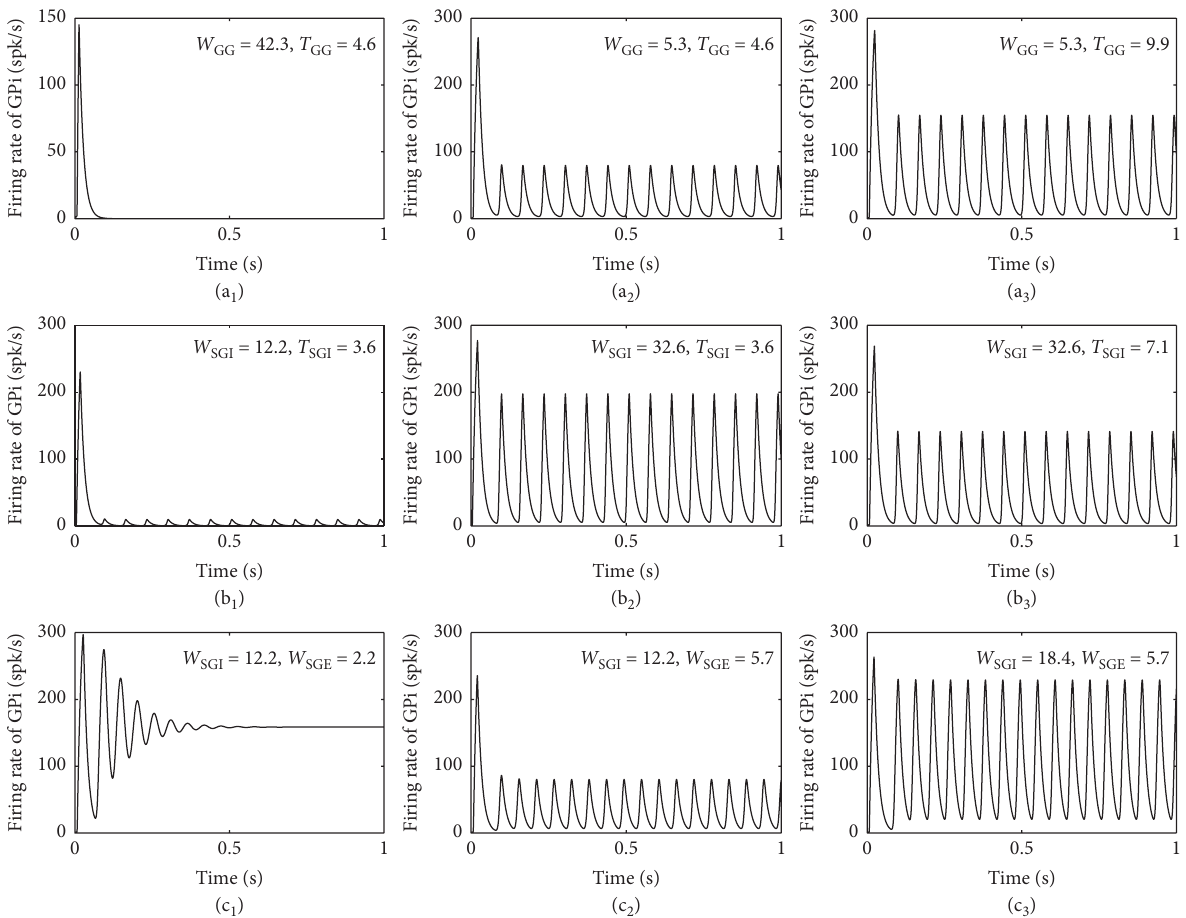
Figure 6: Typical time series of the firing rate of GPi for some parameters: (a W − W SGE SGI